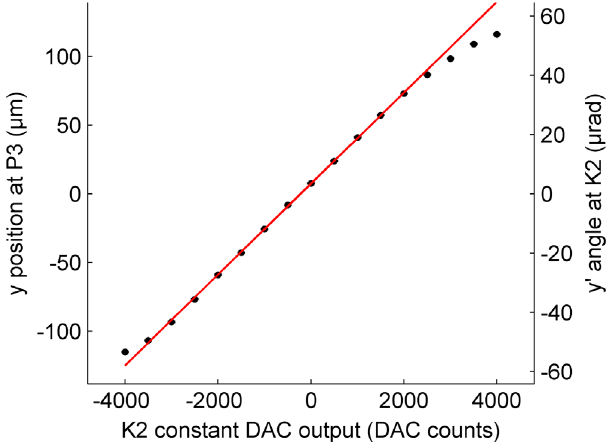
FIG. 15. Vertical beam position at P3 (left-hand scale) versus constant kick applied at K2. The right-hand scale shows the corresponding y 0 kick. The errors on the mean positions are given. The red line is a linear χ 2 fit to the central nine data